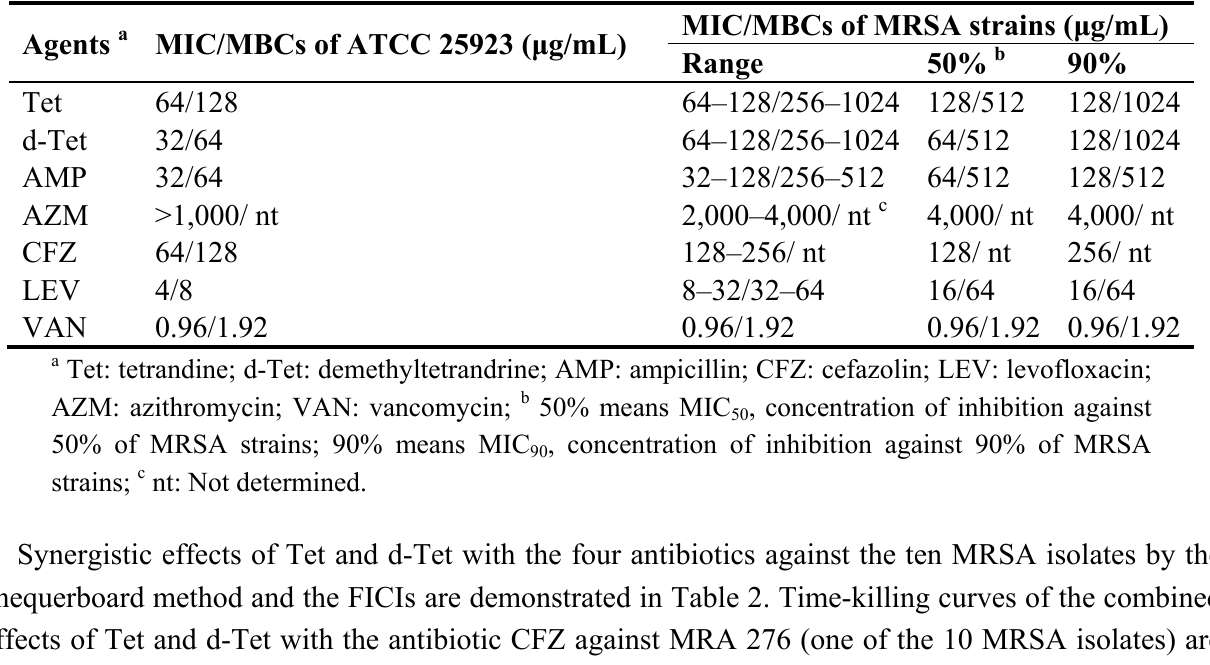
Table 1. MICs/MBCs ( μ g/mL) of Tet, d-Tet and four antibiotics alone against ATCC 25923 and 10 clinical MRSA strains of SCCmec III type.